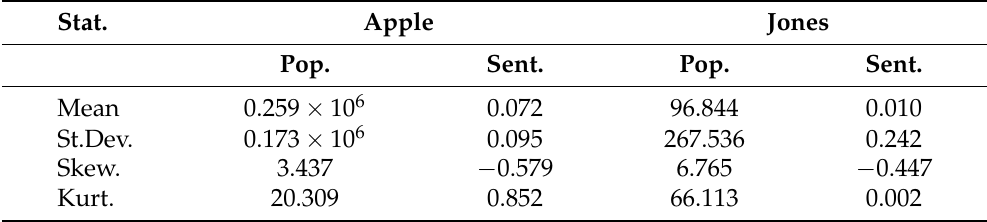
Table 2. Main statistics for Popularity and Sentiment for Apple and Jones. Stat. Apple Jones Pop. Sent. Pop. Sent. Mean 0.259 × 10 6 0.072 96.844 0.010 St.Dev. 0.173 × 10 6 0.095 267.536 0.242 Skew. 3.437 − 0.579 6.765 − 0.447 Kurt. 20.309 0.852 66.113